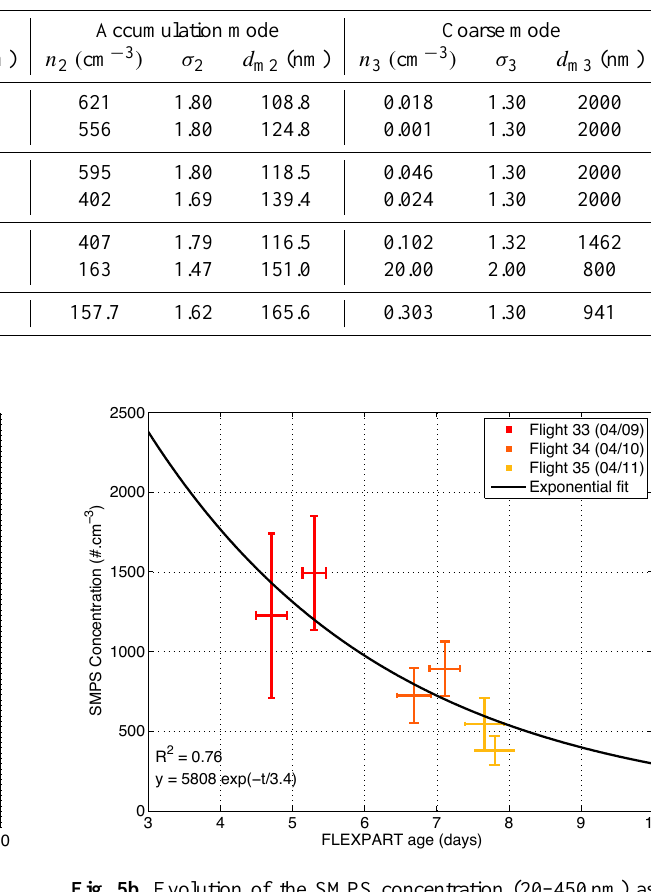
Fig. 5a. Evolution of the Aitken mode mean diameter as a function of the FLEXPART age for the anthropogenic plume. Data points are colour-coded with respect to the flight dates. An exponential fit shown as a black line.